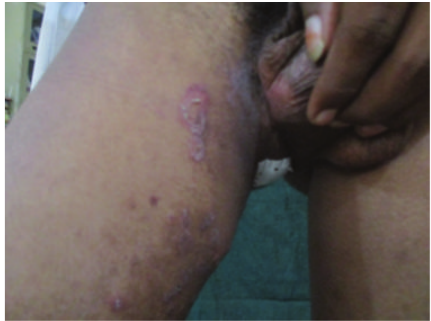
Figure 1: Ulcers seen on the scrotum.